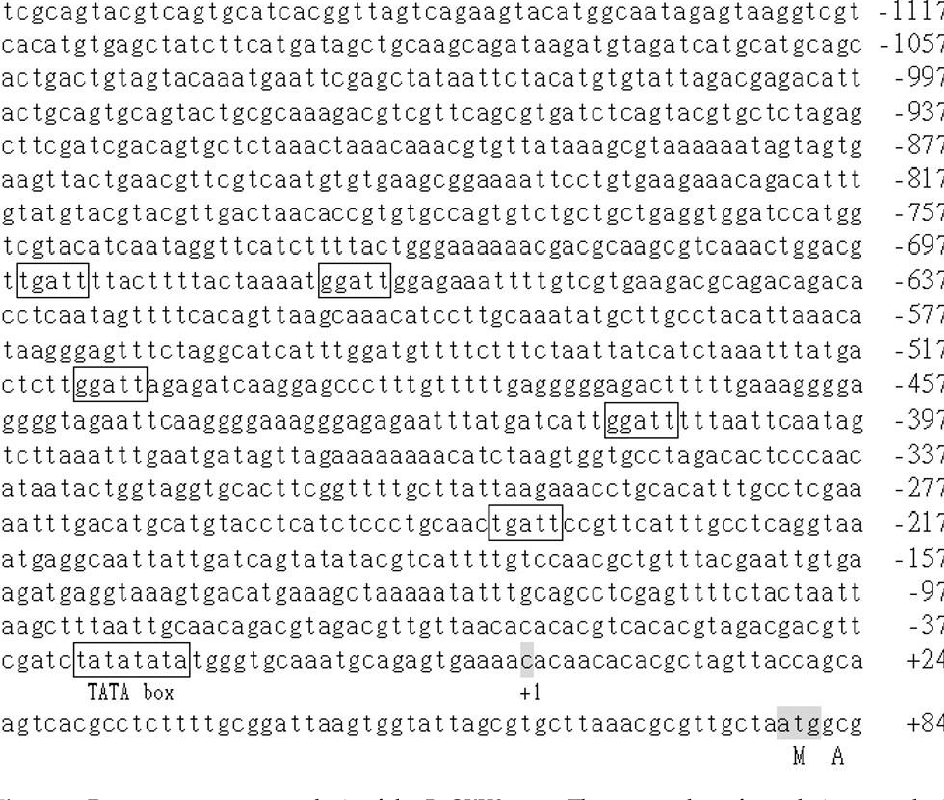
Figure 7. Promoter sequence analysis of the BoCKX3 gene. The start codon of translation was shaded. The predicted transcriptional start site was indicated as “+1”. The putative functional TATA box and five NGATT elements were designated.